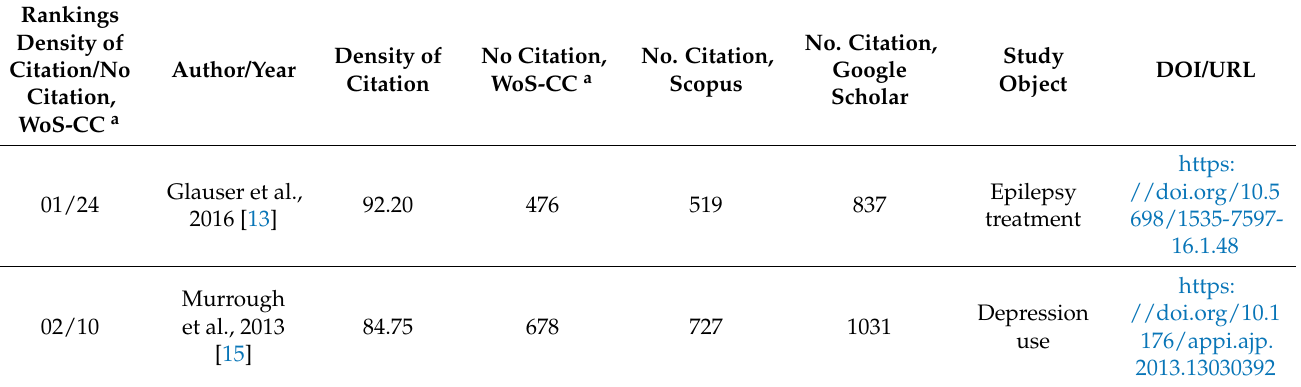
Table 1. The 100 most-cited articles about midazolam considering the citation